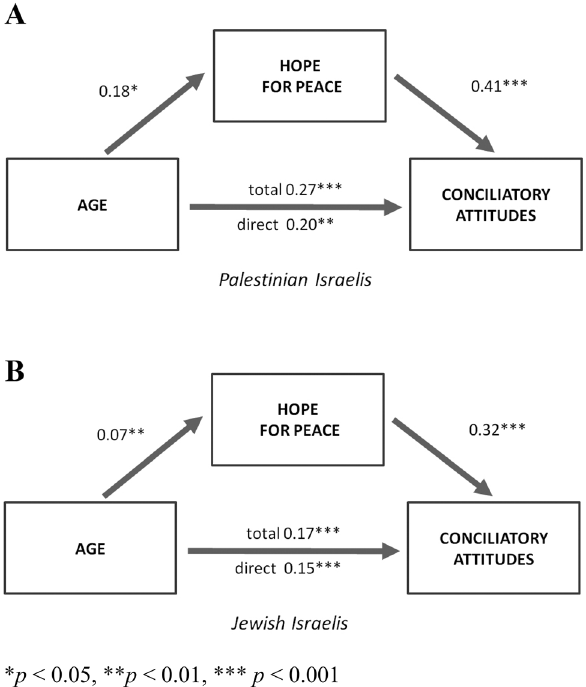
Figure 2. Mediation of age on conciliatory attitudes through hope for peace among Palestinian citizens of Israel ( A ) and Israeli Jews ( B ). Values are standardized beta